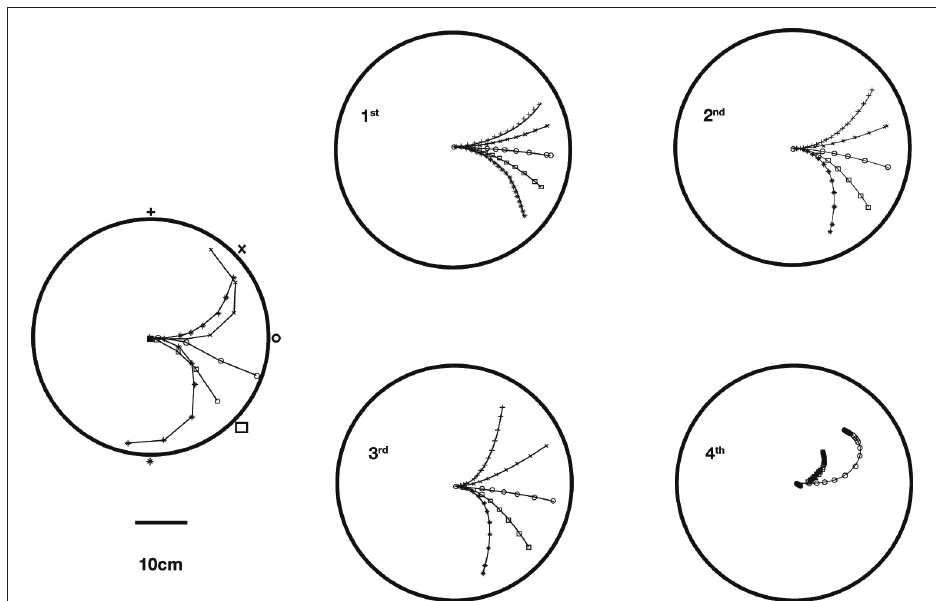
The data for the fit were generated in a separate session, in which stimulation patterns with different frequencies were applied to the two electrodes placed among vestibular axons. The responses were collected from the two recording electrodes in the posterior rhombencephalic reticular nuclei (PRRN) on the right and left side of the midline. Thus, the data were a collection } of points x x y y ( x : stimulus, y : response) i = 1 from the right and left side. These were used to derive, by least squares, the parameters W in Eq.